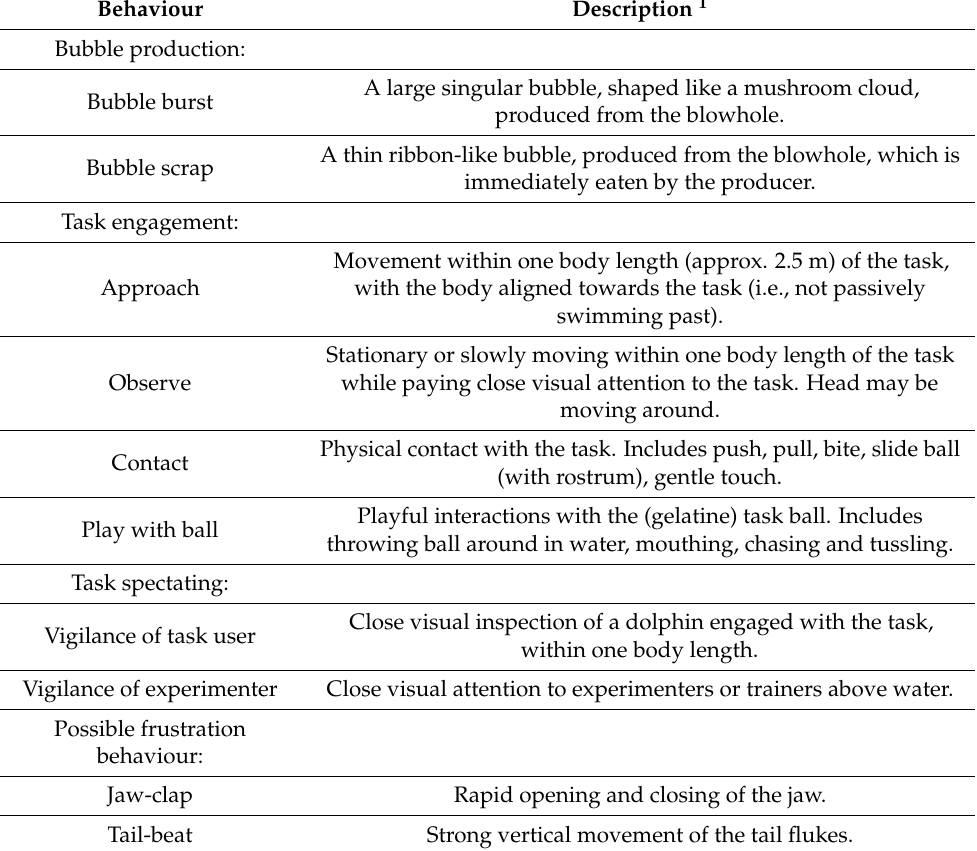
Table 1. Ethogram for captive male dolphins in response to an underwater cognitive